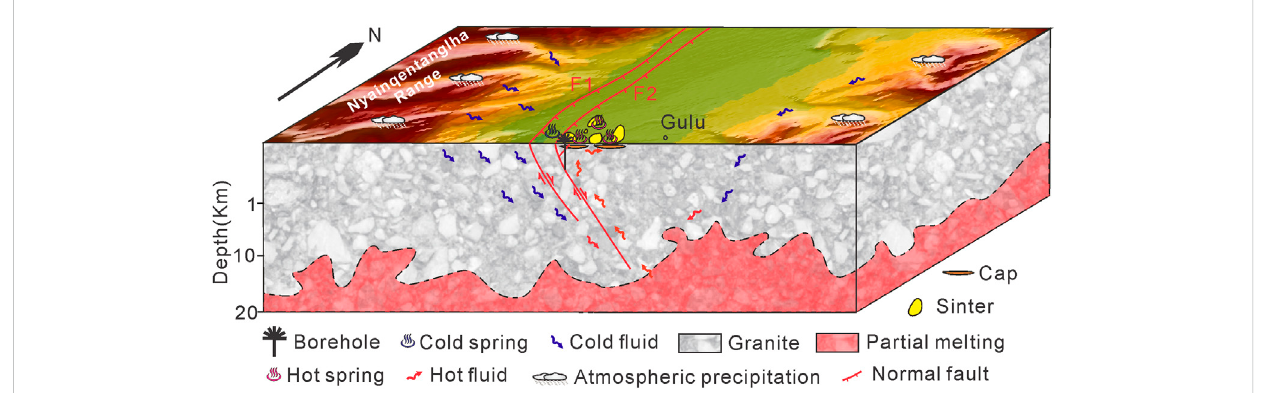
FIGURE 6 Cartoon model of geothermal system in Gulu geothermal fi eld. Atmospheric precipitation feeds the underground fl uids. The cold and hot fl uids mainlymigratealongthefaultsF1andF2,respectively.Thehydrothermalalternationzonesbelow~30 – 50mofsurfacerevealedbyboreholesarethecap of geothermal system of Gulu geothermal fi eld. Partial melting in middle and upper crust drives the geothermal